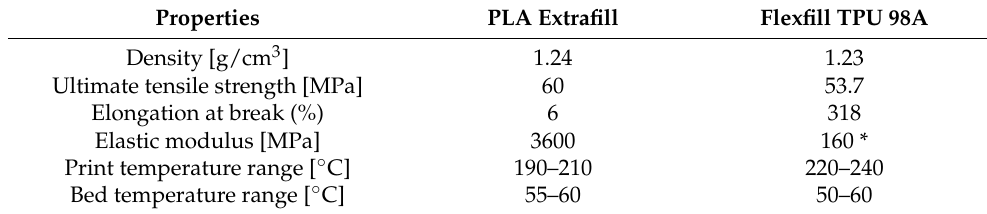
Table 1. Main properties of the chosen materials